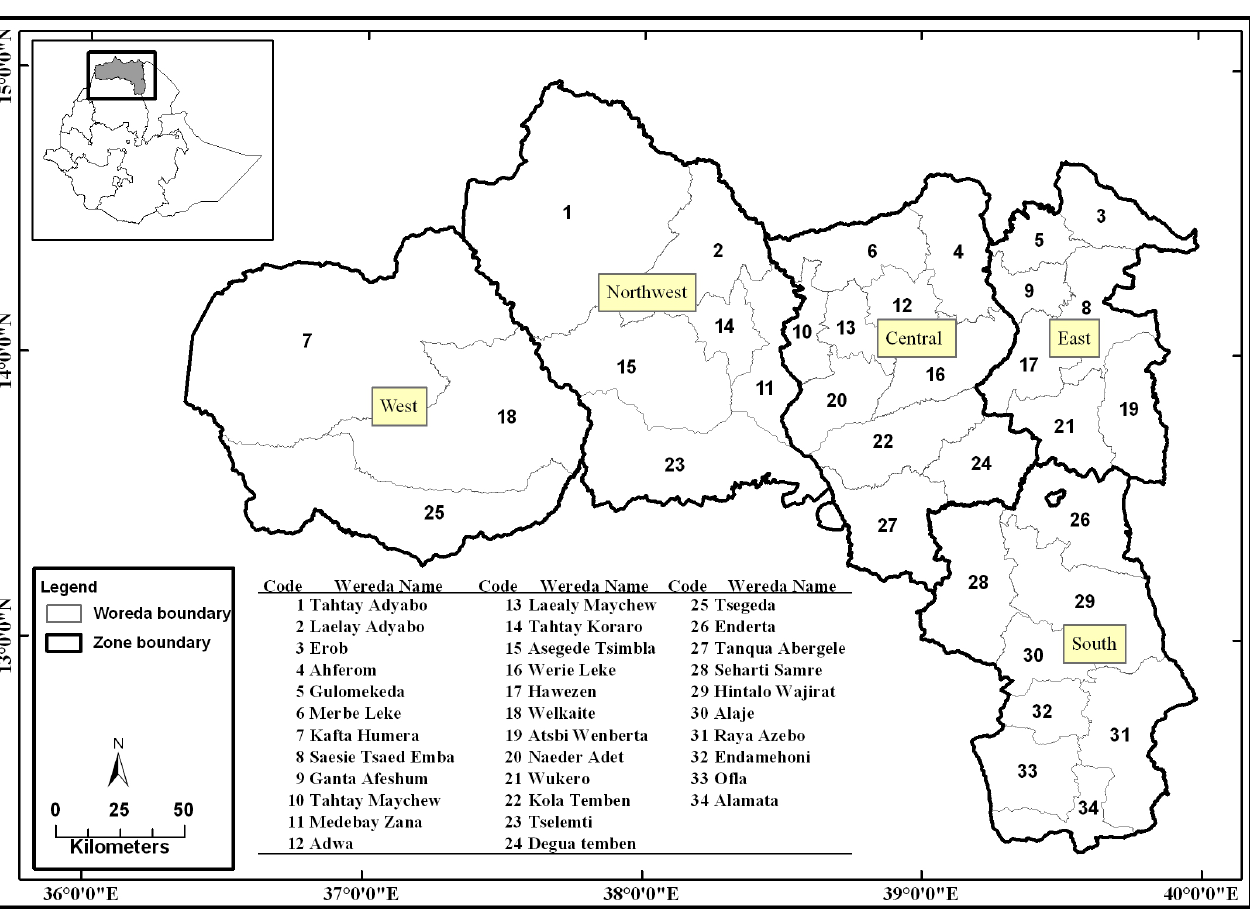
Fig. 1 . Administrative map of Tigray region,